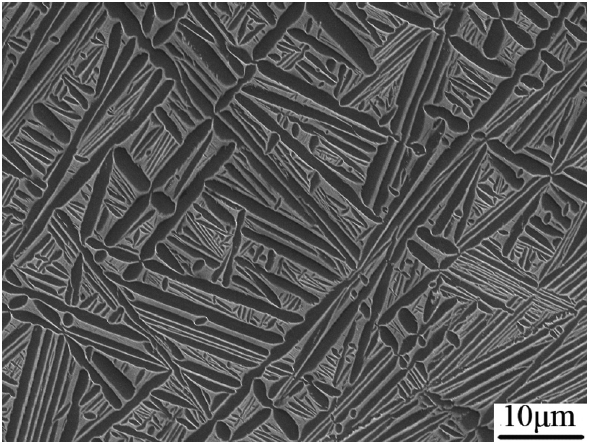
Figure 1: Lamellar starting microstructure of Ti – 6.5Al – 2Sn – 4Zr – 4Mo – 1W – 0.2Si